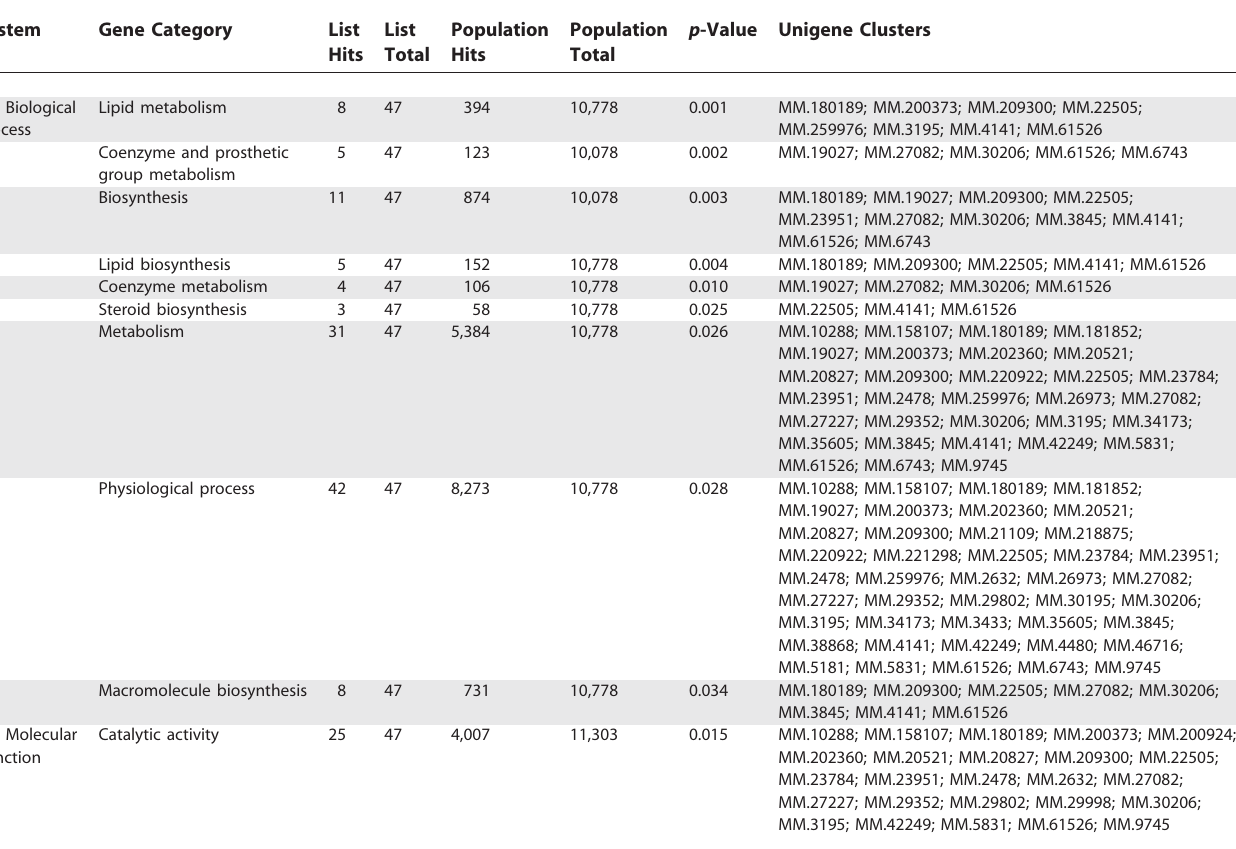
Table 6. Pathway Analysis for Downregulated Genes in Lymphedema versus Normal Control (SAM, FDR , 0.05)